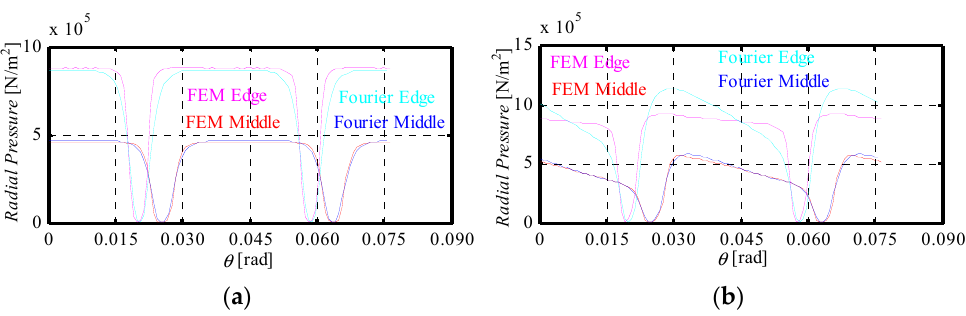
Figure 16. Magnetic pressures on the tooth base in the Qs48p8 machine: ( a ) in open-circuit condition, ( b ) in load condition.